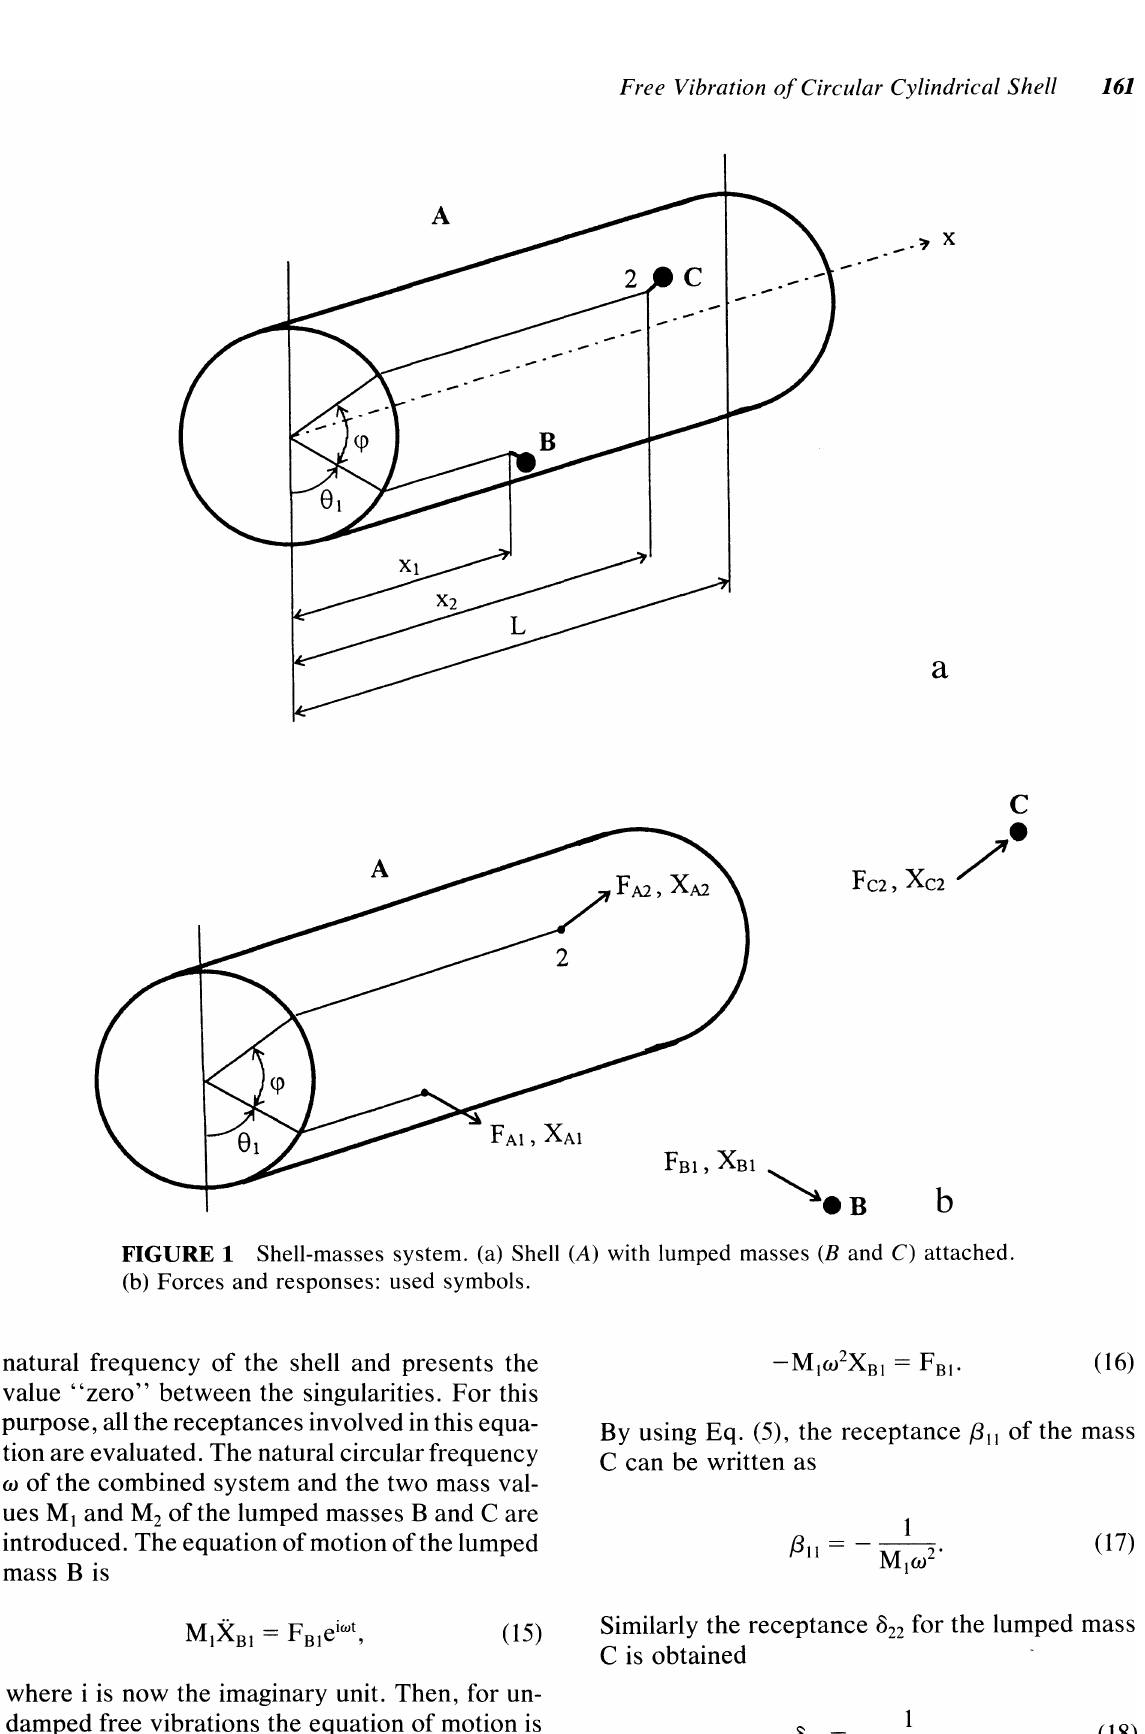
FIGURE 1 Shell-masses system. (a) Shell (A) with lumped masses (B and C) attached. (b) Forces and responses: used